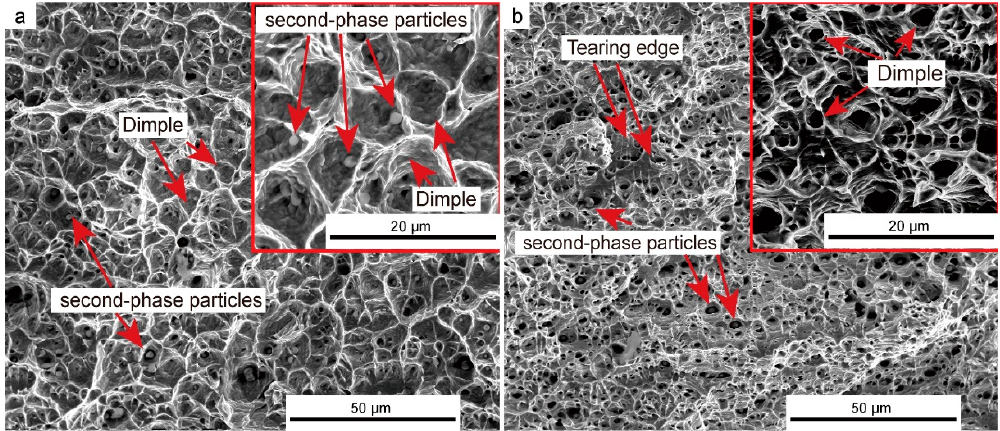
Figure 14. Microfracture morphology of the tensile specimen: ( a ) Horizontal tensile specimen H2, and ( b ) vertical tensile specimen V2.